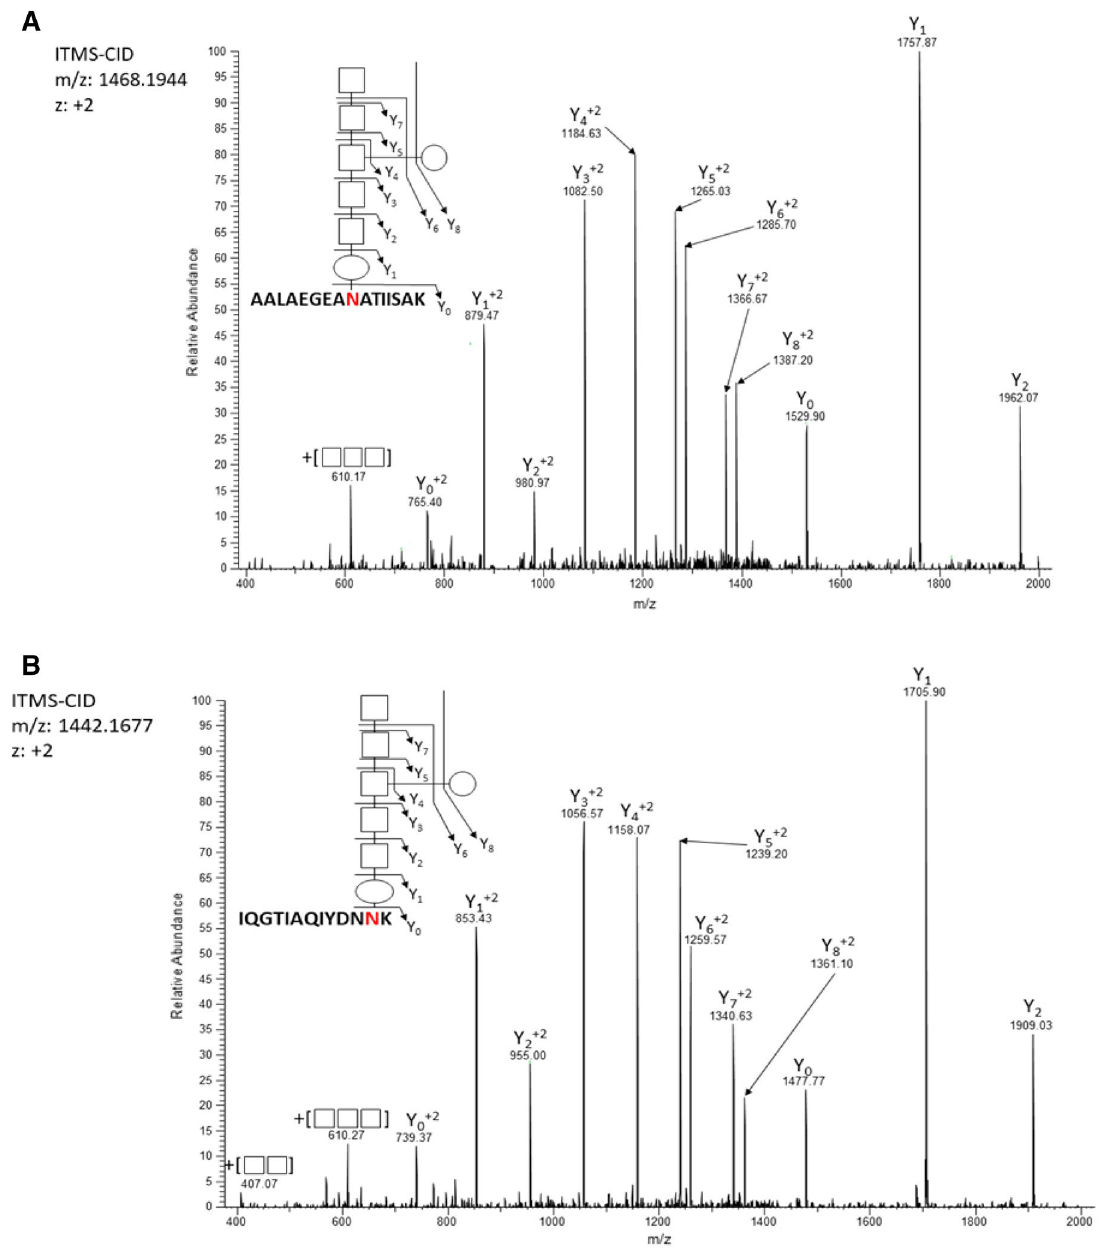
Figure 5. Ion-trap CID-MS spectra of two C. hepaticus HV10 T glycopeptides. Spectra represent fragmented ions produced from the N- glycan. ( A ) C. hepaticus HV10 T glycopeptide 23 IQGTIAQIYDNNK 36 with a delta mass of 1405.56 Da. ( B ) C. hepaticus HV10 T glycopeptide 266 AALAEGEANATIISAK 282 with a delta mass